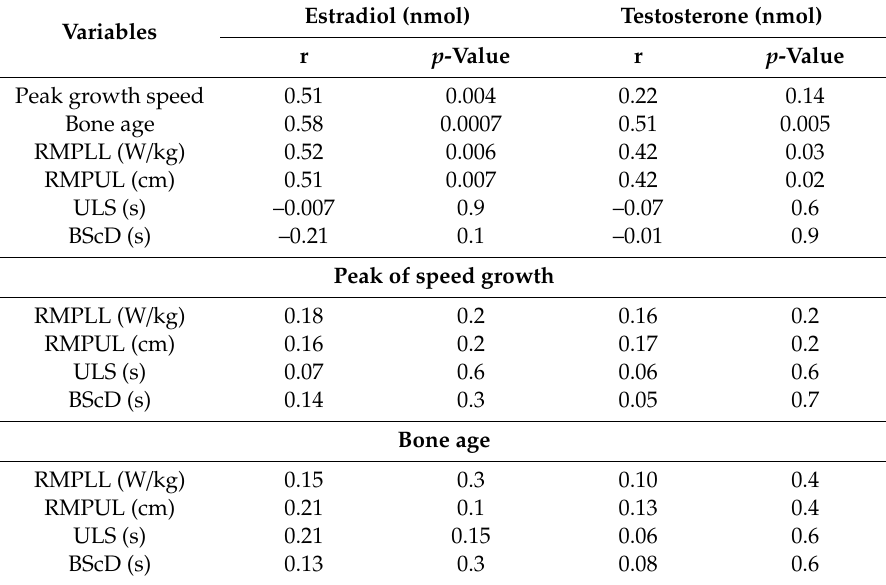
Table 2. Correlation matrix between hormones and maturation and physical aspects. Variables